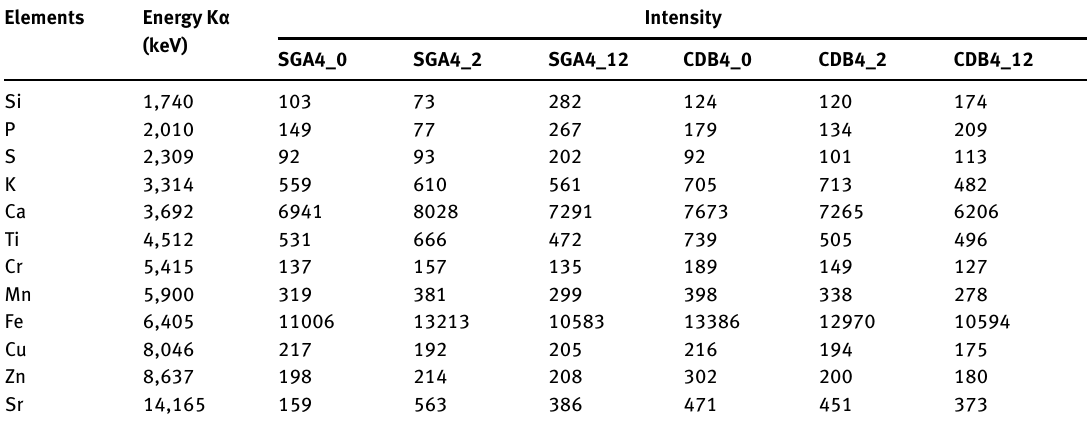
peak intensities of the samples of the series SGA4 and CBD4 without firing (#_0), cooked at 400°C (#_2) and 900°C Table 4. K α (#_12)